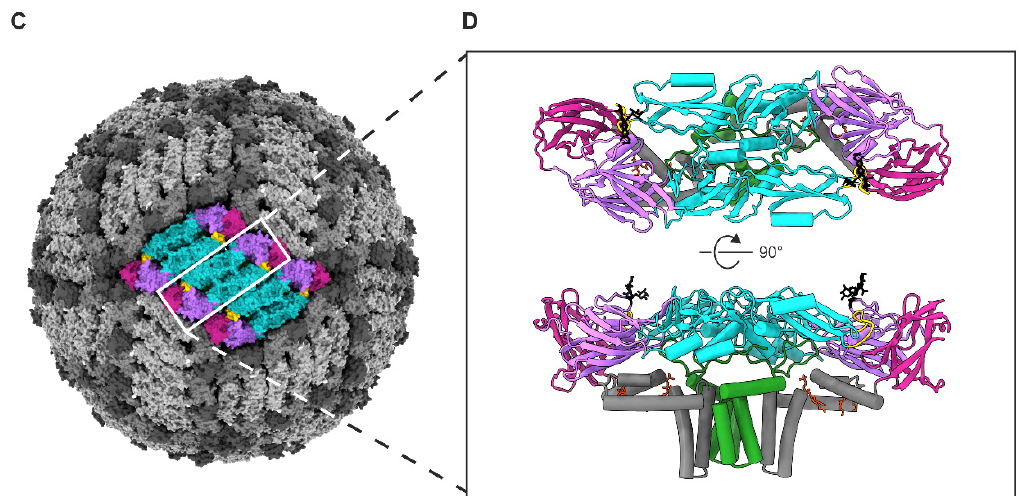
Figure 1. TBE virion cryoEM reconstruction and atomic model. ( A ) Radially coloured isosurface representation of the reconstruction viewed down a two-fold axis of symmetry, shown at 2.35 σ above the mean. The symmetry axes are indicated with an ellipse (two-fold), a triangle (three-fold), and star (five-fold). The colour key is the same as in panel B. ( B ) A 60 Å central slice of a radially coloured isosurface representation of the reconstruction viewed down a two-fold axis of symmetry, at 2.35 σ above the mean. ( C ) Surface representation of the reconstruction, with a raft of three E–M–M–E heterotetramers highlighted, viewed down a two-fold axis of symmetry. ( D ) Cartoon representation of the E–M–M–E heterotetramer shown from the top and side views. ( C , D ) The E domains are coloured in purple (domain I), turquoise (domain II), magenta (domain III), grey (domain IV), the E fusion loop is coloured in gold, the E Asn154 glycan motif in black, the M protein in green, and the phosphatidylcholine (PC) lipids in red-orange.